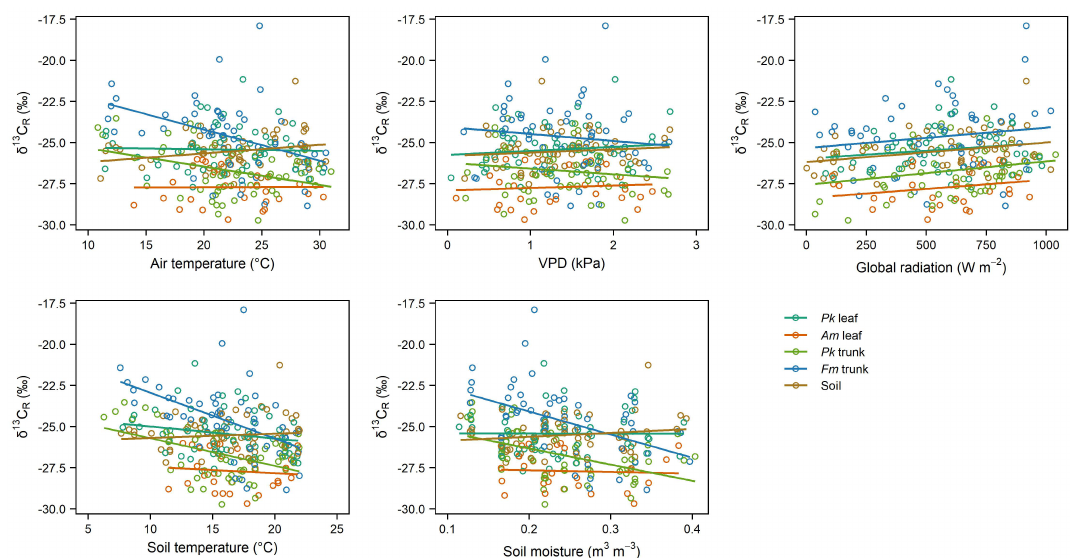
Figure 6. Relationship between the δ 13 C R of di ff erent ecosystem organic pools and environmental factors. The data shown are the δ 13 C R of each measurement and the environmental factors of the corresponding half hour when the δ 13 C R was measured. VPD, vapor pressure deficit; Pk , Korean pine ( P. koraiensis ); Fm , Manchurian ash ( F. mandshurica ); Am , Mono maple ( A. mono ); Qm , Mongolian oak ( Q. mongolica ). Table 1. Pearson correlation coe ffi cients for the δ 13 C R from the C pools with environmental factors in the growing season. The δ 13 C R of each measurement and the corresponding half-hour meteorological data were used to conduct this analysis.